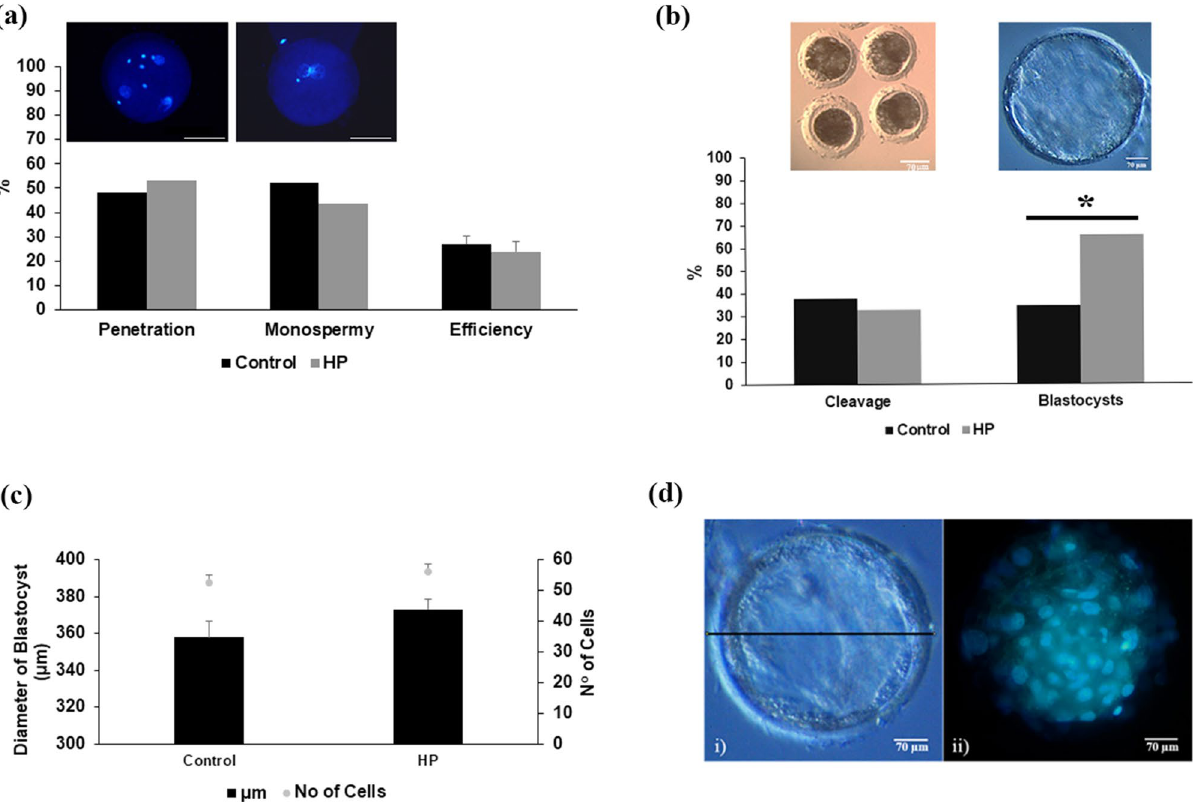
Figure 4. Effect of haptoglobin on in vitro embryo production and development. ( a ) Percentage of penetration, monospermy and efficiency rates during the gametes co-incubation with haptoglobin (n = 7 replicates) (93 and 107 oocytes were evaluated for control and haptoglobin groups, respectively) ( b ) Percentage of zygote cleavage (at 48 h post-insemination) and blastocyst development (at 7 days post-insemination) were evaluated (n = 3 replicates). Blastocyst rate was calculated from percentage of cleaved embryos. (*) between experimental groups indicates significant differences (p < 0.05) (104 and 94 zygotes were evaluated for control and haptoglobin groups, respectively). ( c ) Left Y-axis represents the diameter (µm) in represented and right Y-axis represents the total number of the cells per blastocysts evaluated on day 7 post insemination. The data are expressed as mean ± standard error (37 and 31 blastocysts from control and haptoglobin groups were evaluated) ( d) , (i) The diameter of the blastocyst was measured using ImageJ® program, and (ii) total number of cells was evaluated from blastocyst stained with